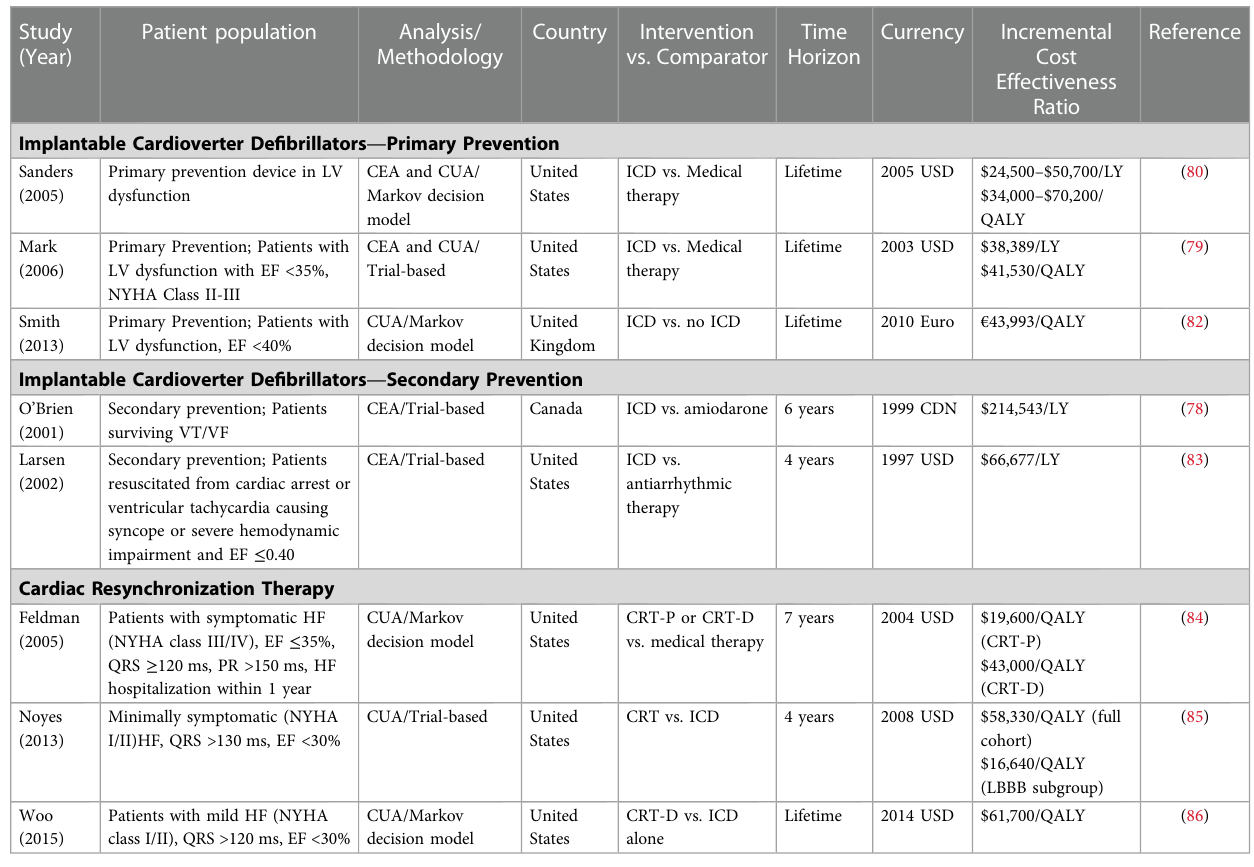
TABLE 4 Selected economic evaluations of implantable cardioverter de fi brillator and cardiac resynchronization therapy